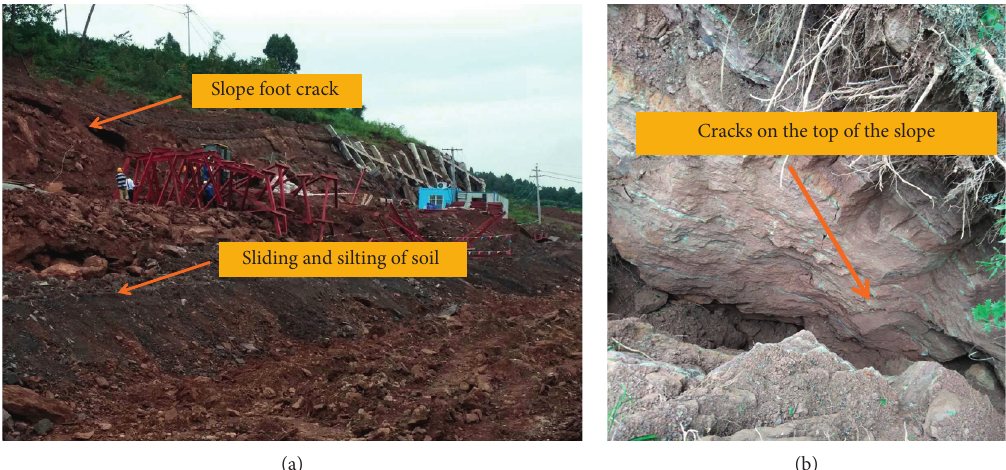
Figure 10: Engineering site pictures. (a) Slope foot. (b) Top of the slope.